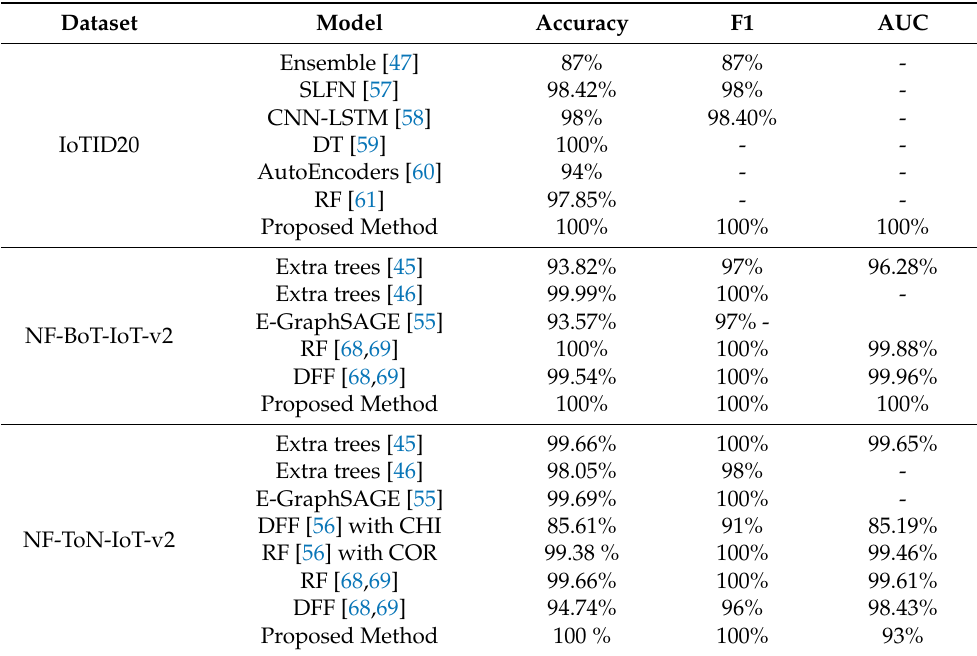
Table 5. Performance comparison between the proposed method and prior methods on